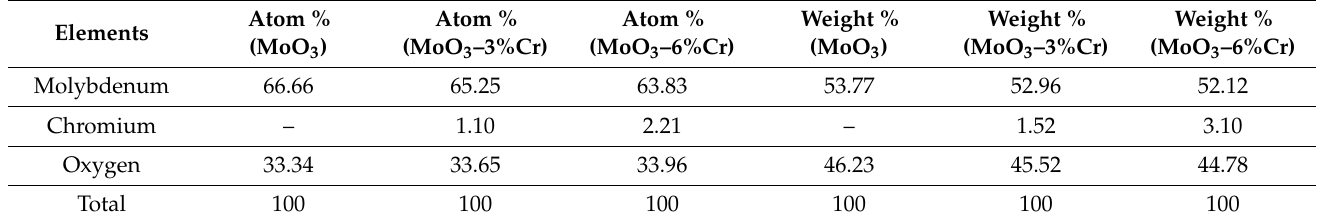
Table 2. Elemental compositions by atom % and weight % of the Cr-doped MoO 3 samples.